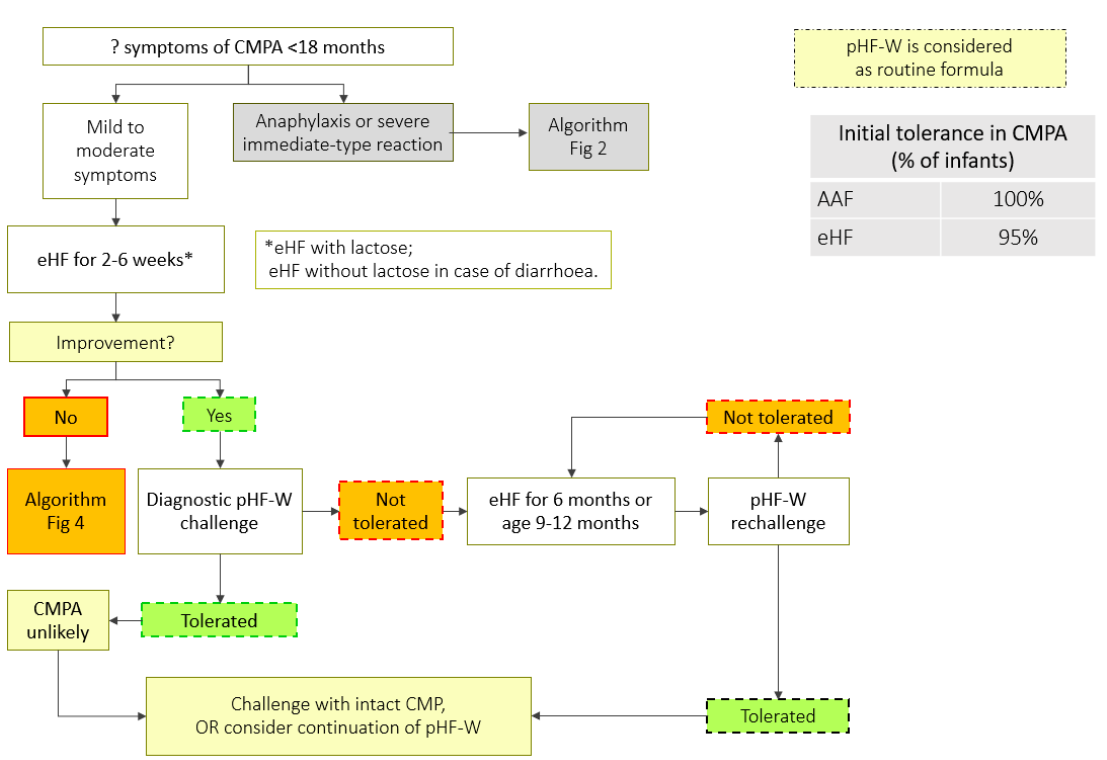
Figure 3. CMPA step-down treatment algorithm (mild-to-moderate symptoms). AAF: amino acid based formula; eHF: extensively hydrolyzed formula; pHF-W: partially hydrolyzed formula-Whey; CMPA: cow’s milk protein allergy; CMP: cow milk protein. * use eHF without lactose in case of